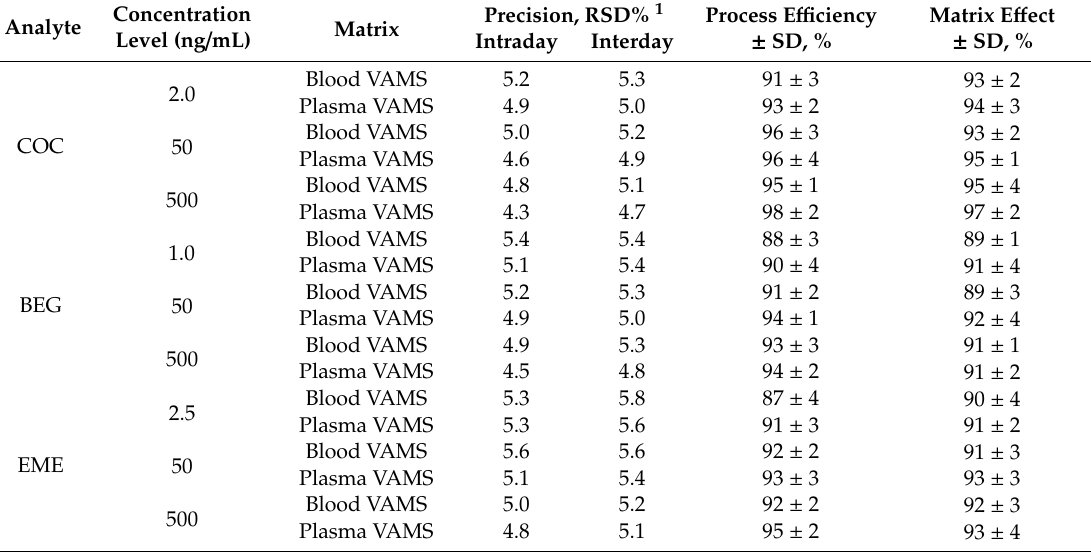
Table 3. Process e ffi ciency, precision and IS-corrected matrix e ff ect assay results.